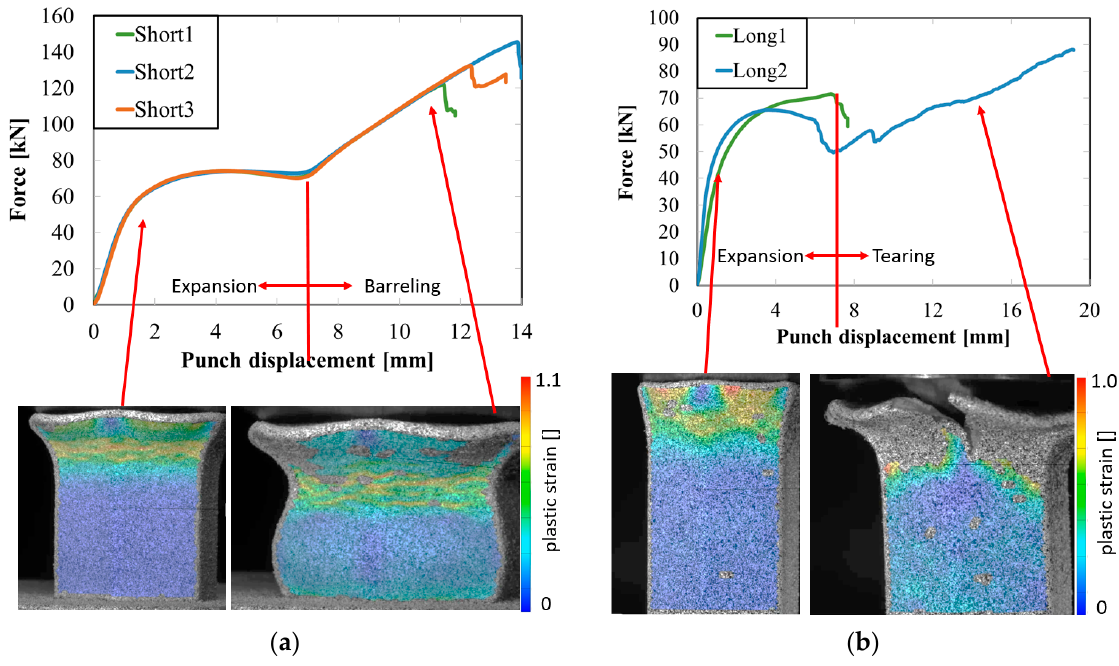
Figure 20. Records of honeycomb compression test: ( a ) force-punch displacement records for a SHORT honeycomb compression test, ( b ) force-punch displacement records for LONG honeycomb compression test.